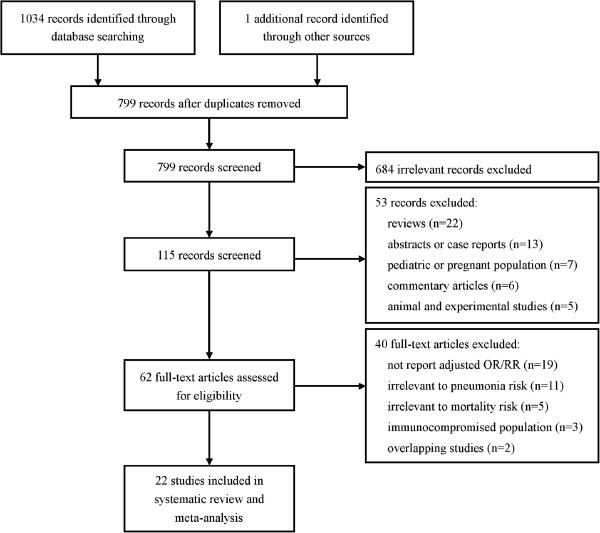
Flow of study identification, inclusion and exclusion.